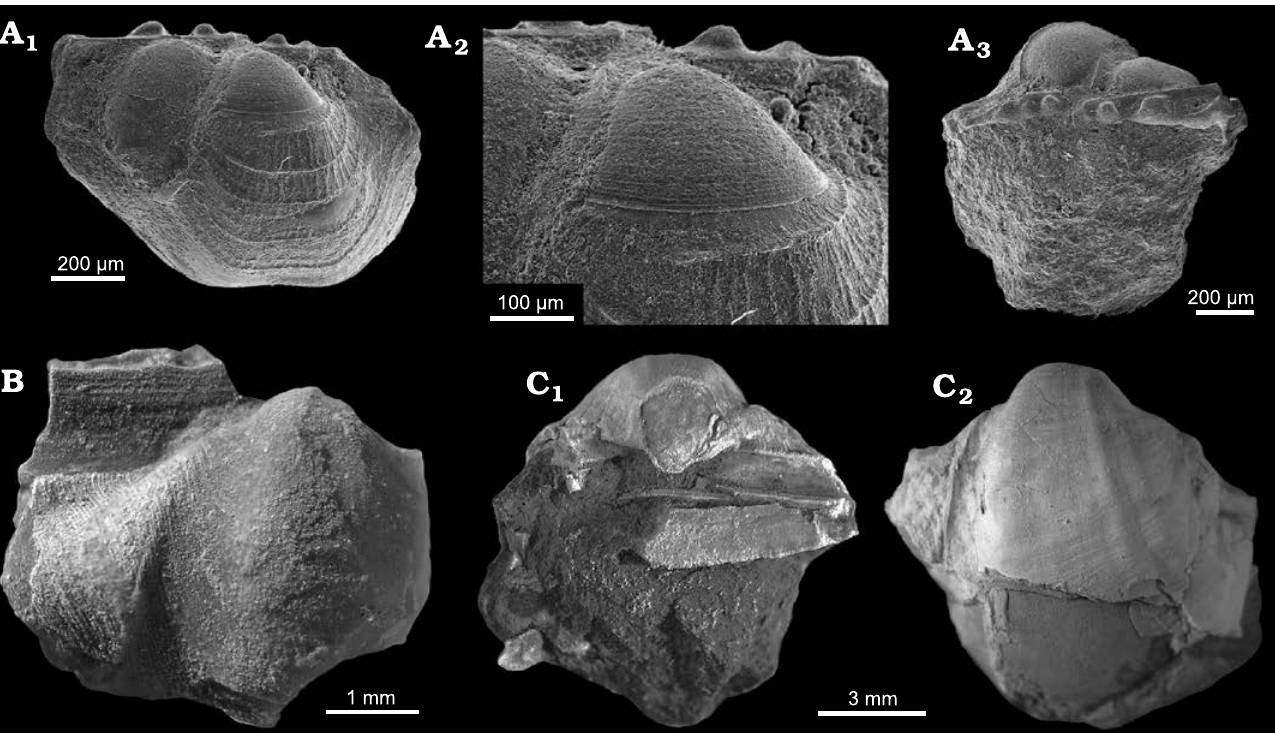
Fig. 27. Cassianellid bivalves from Lago Antorno, northern Italy, Cassian Formation, Carnian, Upper Triassic. A . Cassianella spp., PZO 12886, in lateral view (A 1 ); A 2 , lateral view showing prodissoconch; A 3 , internal view with partly preserved hinge. B . Cassianella beyrichi Bittner, 1895, PZO 12861, in lateral view. C . Cassianella beyrichi Bittner, 1895, PZO 12862, in internal (C 1 ) and lateral (C 2 )